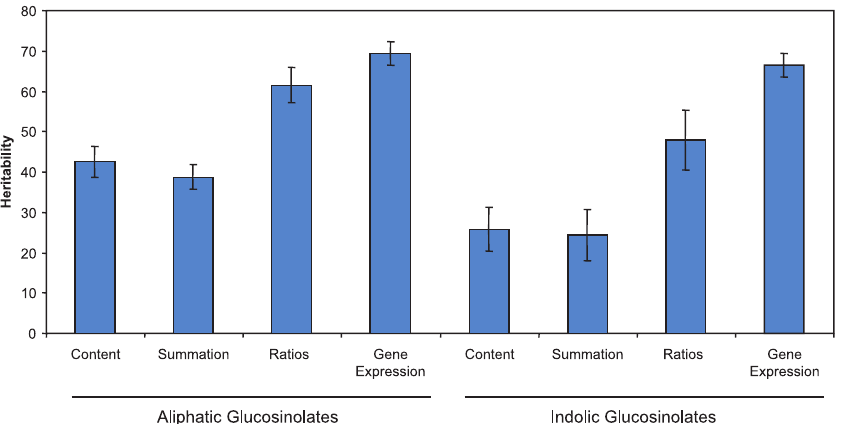
Figure 2. Estimated Heritability for Different Glucosinolate Traits Heritability of glucosinolate traits for both the aliphatic and indolic glucosinolate pathways as estimated from 403 Bay-0 3 Sha RILs. These include the Content ¼ content of individual glucosinolates, Summation ¼ the summation of various glucosinolates, Ratio ¼ the ratio of glucosinolates to each other, and Gene Expression ¼ the expression of glucosinolate biosynthetic genes. Heritability for Gene Expression was estimated using the RMA obtained expression values. Error bars show standard error of the mean.